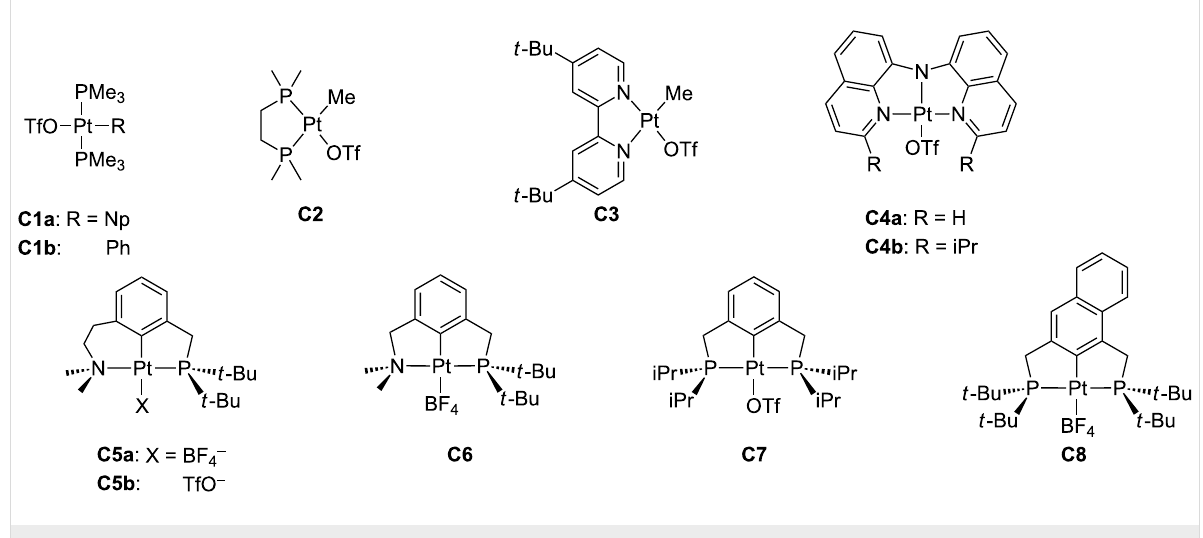
Figure 9: Counteranion coordination in T-shaped Pt(II)